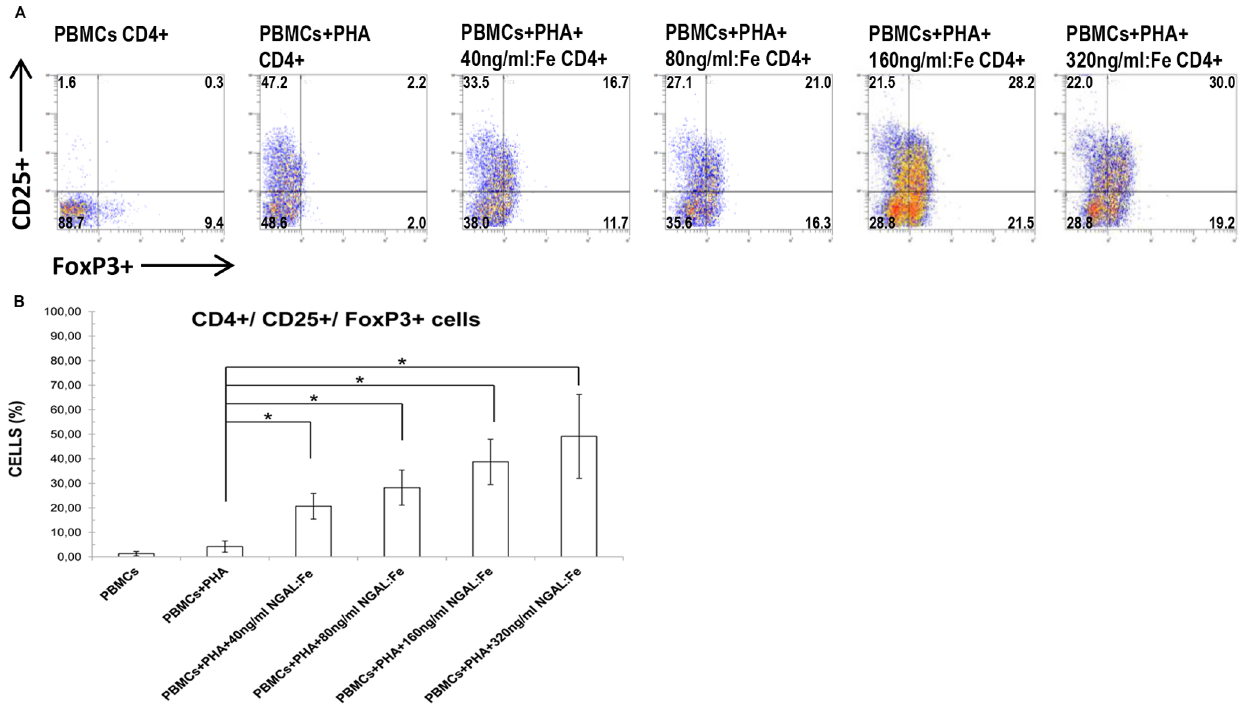
Figure 3. Effect of NGAL on the percentage of CD4 + /CD25 + /FoxP3 + cell population. A). The percentage of CD4 + /CD25 + /FoxP3 + cells in PHA-activated PBMCs after stimulation with increasing concentrations of NGAL: Enterobactin:Iron 40 ng/ml, 80 ng/ml, 160 ng/ml, and 320 ng/ml), raised in a dose dependent manner. Data are representative of 8 independent experiments. The number in each quadrant represents the percentage of CD25 + /FoxP3 + cells on gated CD4 + cells of the total population. B) Data are expressed as percentages of CD4 + /CD25 + /FoxP3 + cells. Means 6 SD; n = 8. *p , 0.05.